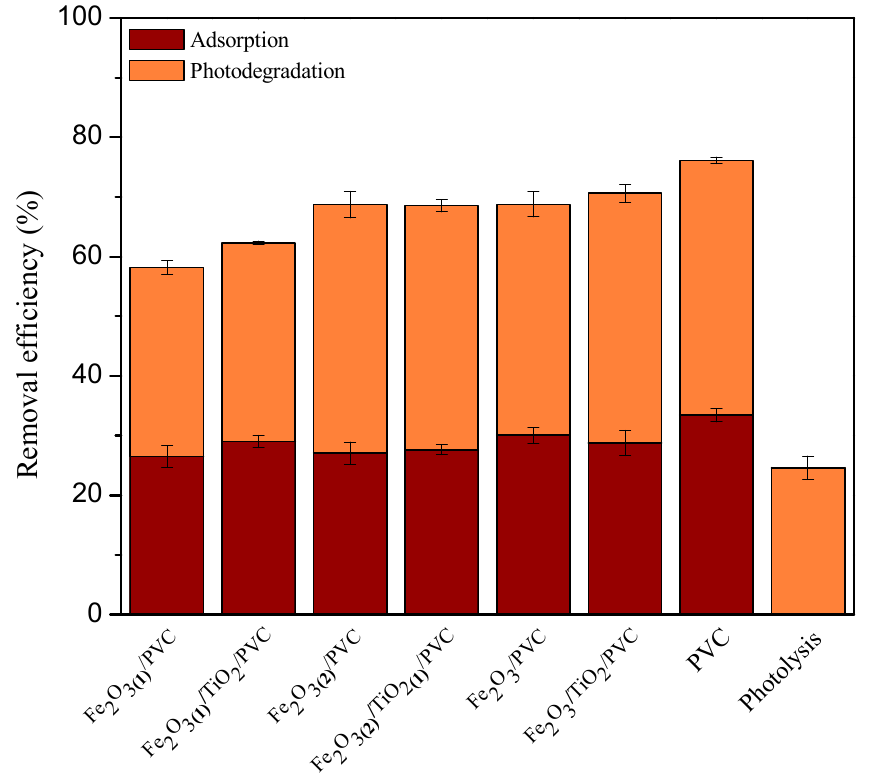
Figure 4. Contribution of adsorption and photodegradation under SSR (calculated after 60 min Figure 4. C о ntribution of ads о rption and ph о todegradation under SSR (calculat е d after 60 min о f 361 of processes) for MB removal efficiency ( c 0 = 2.45 · 10 − 2 mM) in the presence of 29 tablets of processes) for MB removal efficiency ( c 0 = 2.45 ∙ 10 − 2 mM) in the pres е nce of 29 tabl е ts of 362 Fe 2 O 3 /TiO 2 /PVC nanocomposites at a stirring rate of 490 Fe 2 O 3 /TiO 2 /PVC nanocomposites at a stirring rat е of 490 rpm. 363